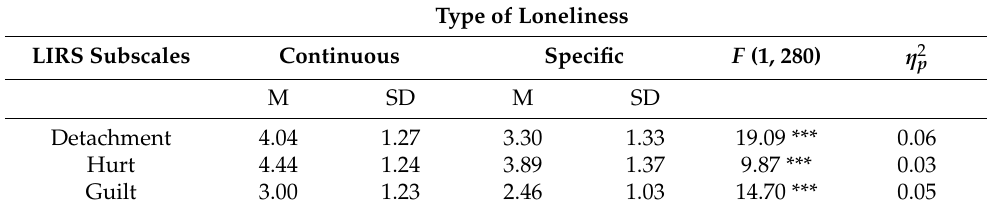
Table 7. Descriptive and Inferential Statistics of LIRS by Type of Loneliness. Type of Loneliness LIRS Subscales Continuous